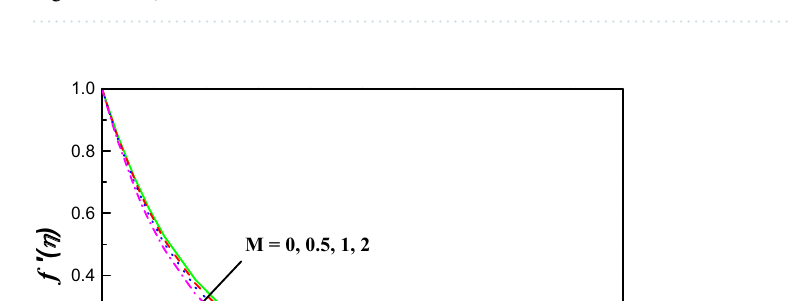
Figure 3. θ(η) variation vs. K .